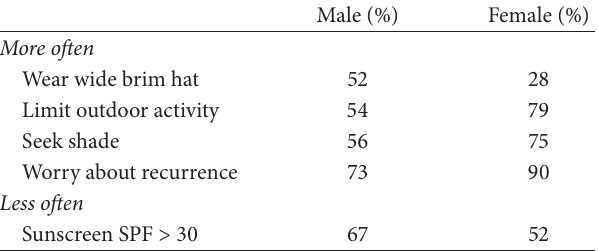
Table 2: Results showed that a larger percentage of females compared to males adopted behavioral changes to prevent future cutaneous melanoma, with the exception of the wide brim hat. A majority of both females and males used sunscreen of at least SPF 30 less often than prior to